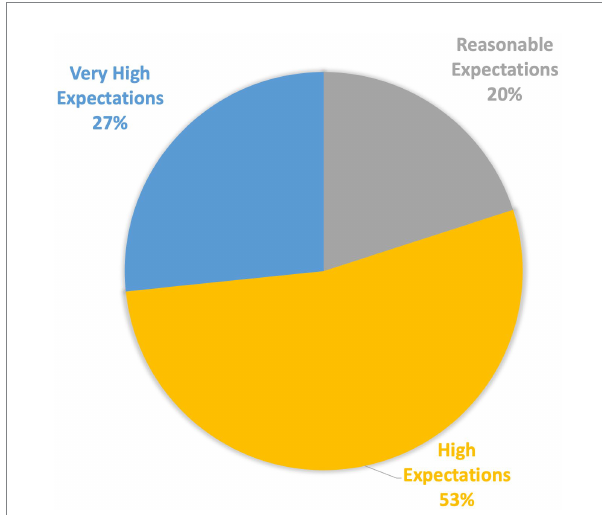
FIGURE 1 Students’ expectations before joining the case-based learning program. A survey was conducted among students before they joined the study, asking them to share their expectations. The graph shows that 80.0% of the respondents anticipated that participation in the study group would be